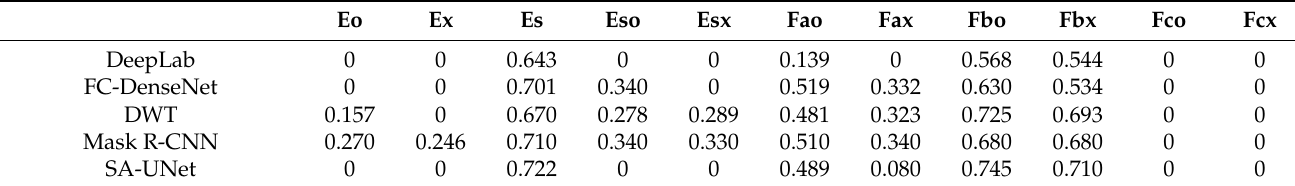
Table 5. Comparison of the mean IoU of each label achieved by each